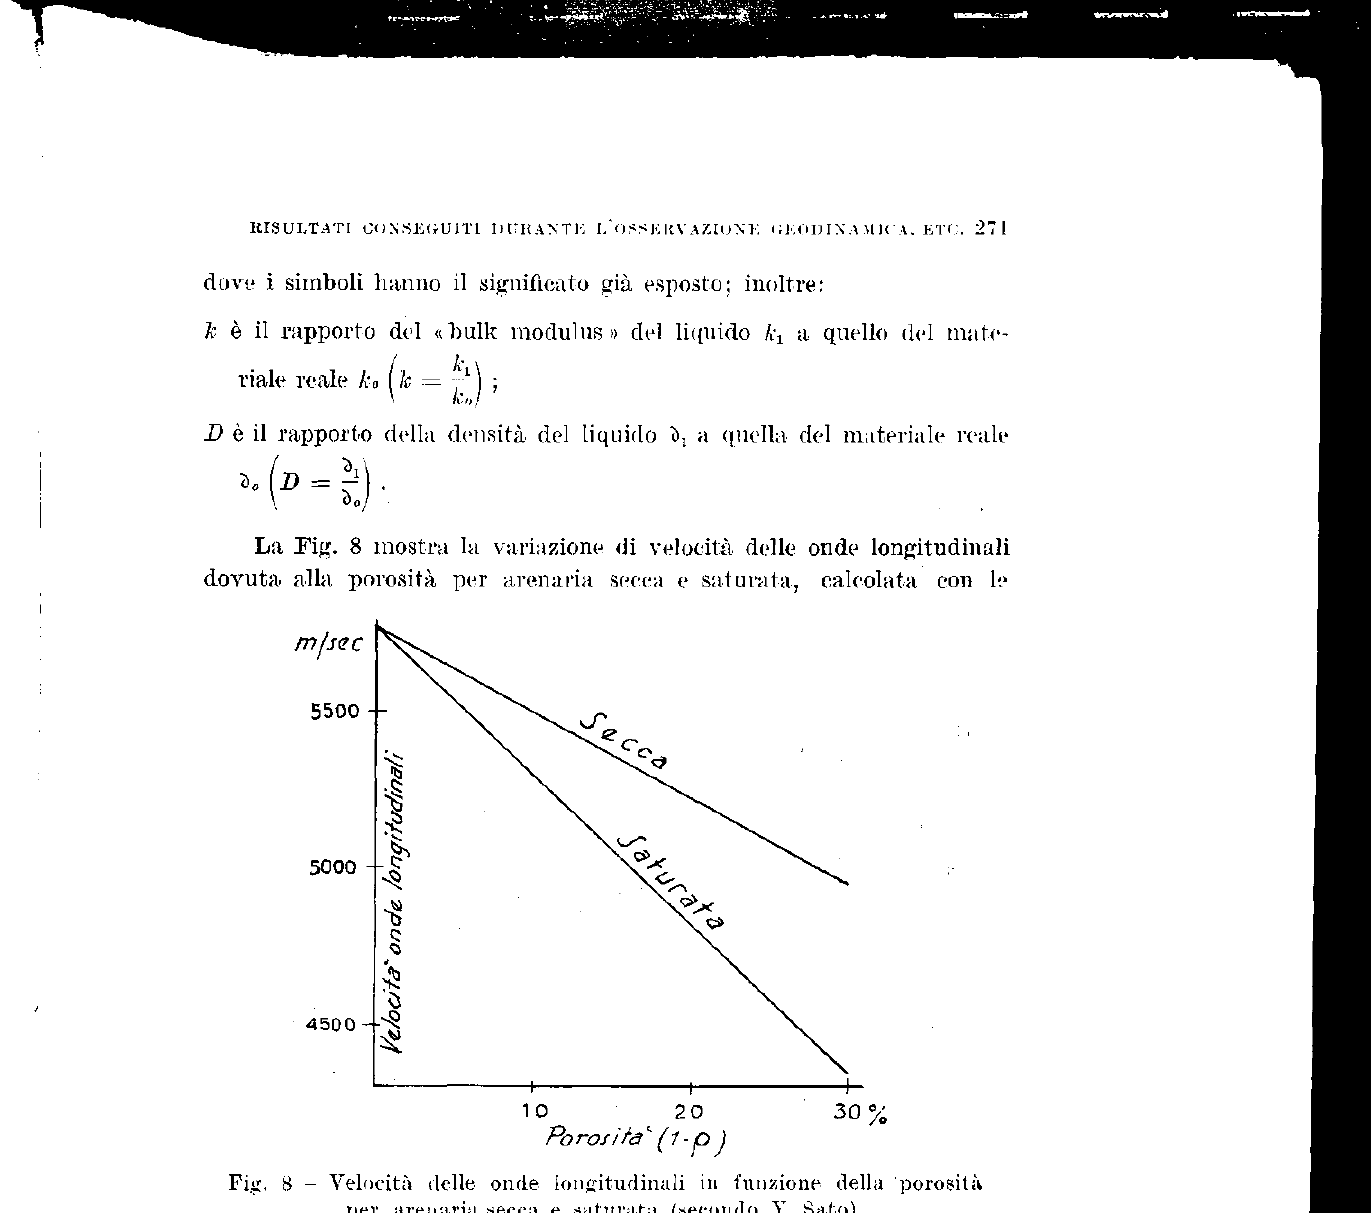
per arenaria secca e saturata (secondo Y.